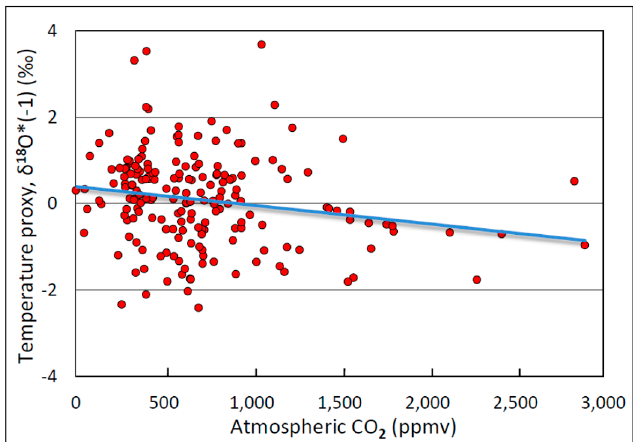
Figure 6. Scatter plot of linearly-detrended temperature-proxy data averaged in one-My bins from 425 to 0 Mybp versus atmospheric carbon dioxide concentration. The negative correlation coefficient ( R = − 0.19, n = 206) is discernibly different from zero ( p = 0.006) but weak ( R 2 = 0.036). The trendline was fitted by the method of least squares.